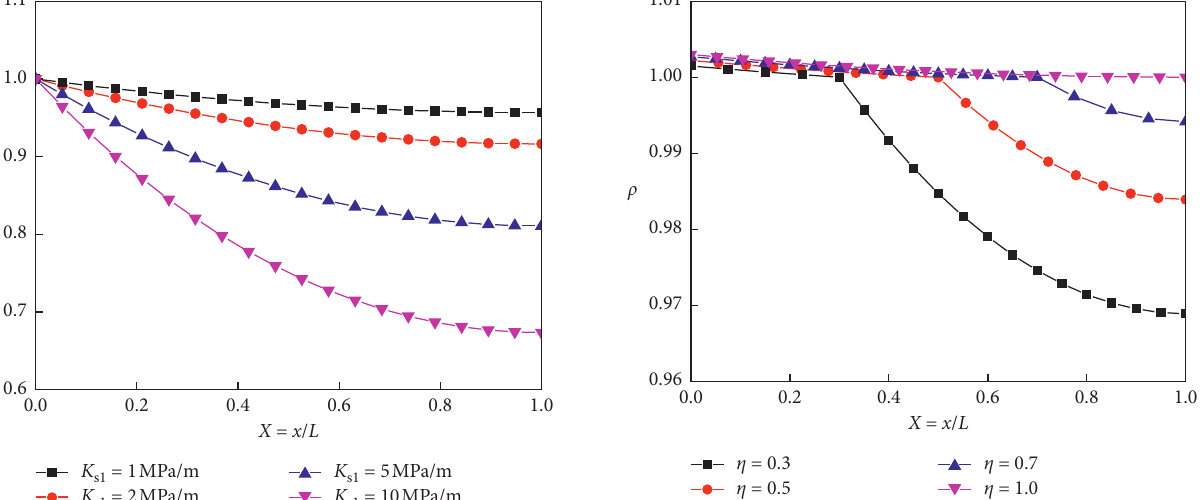
Figure 13: Effect of the interface frictional resistance at stage I on K s 1 .